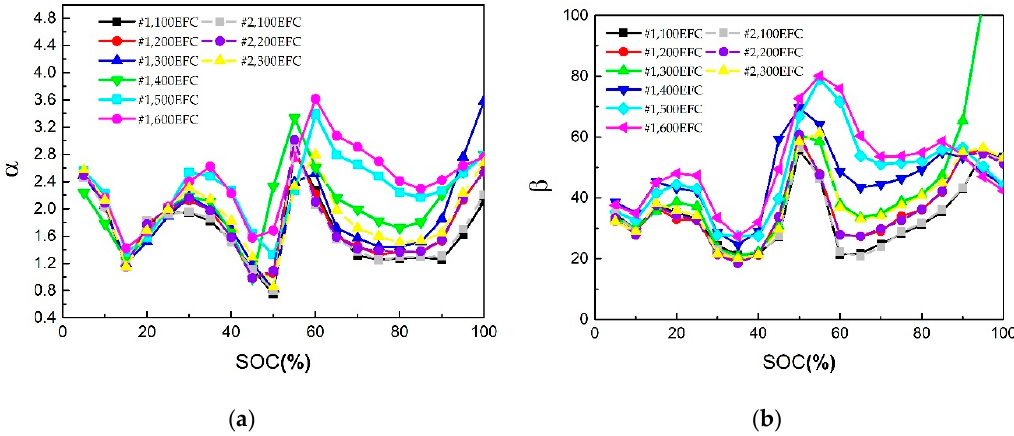
Figure 7. Relationships between relaxation model parameters and SOC under different aging states after charging condition. ( a ) results of α ; ( b ) results of β .